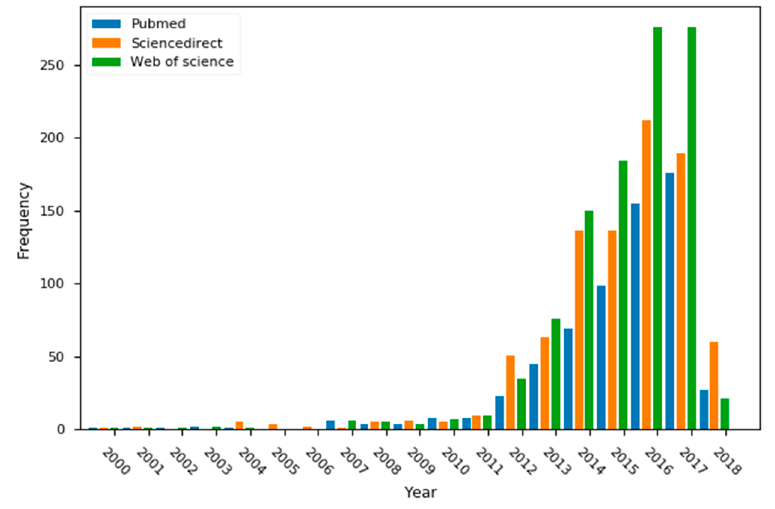
Figure 1. Frequency of the “bromodomain” keyword in three major search engines during the past 18 years. Biomolecules 2018 , 8 , x FOR PEER REVIEW